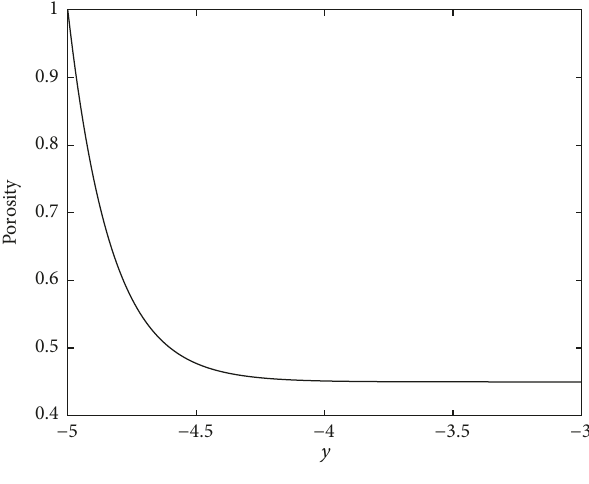
Figure 1: Varying